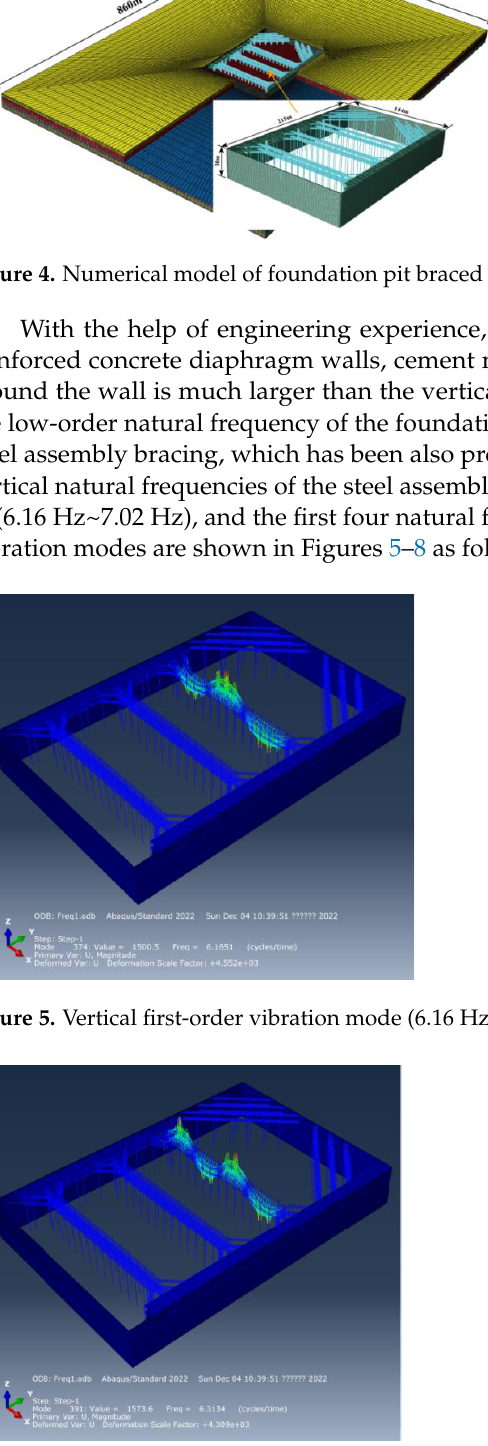
Figure 4. Numerical model of foundation pit braced by section steel assembly. Table 2. Physical and mechanical parameters of steel assembly bracing.